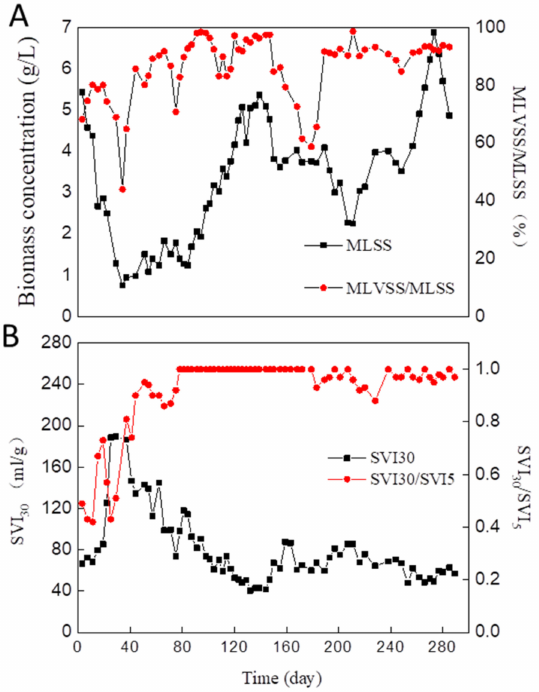
Figure 1. Characteristics of the sludge during the long-term operation period: ( A ) Biomass concen- tration and MLVSS/MLSS; ( B ) SVI 30 and SVI 30 / SVI 5